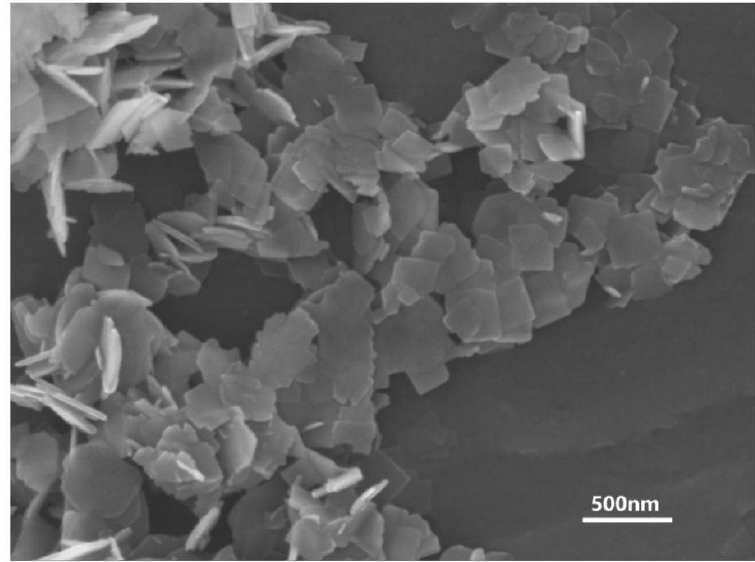
Figure 1. The SEM photograph of the hydrothermal precursors.